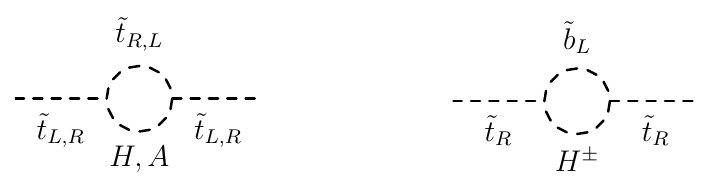
Figure 10. Left : neutral heavy Higgs contribution to the left- and right-handed stop self-energies. Right : charged Higgs contribution to the right-handed stop